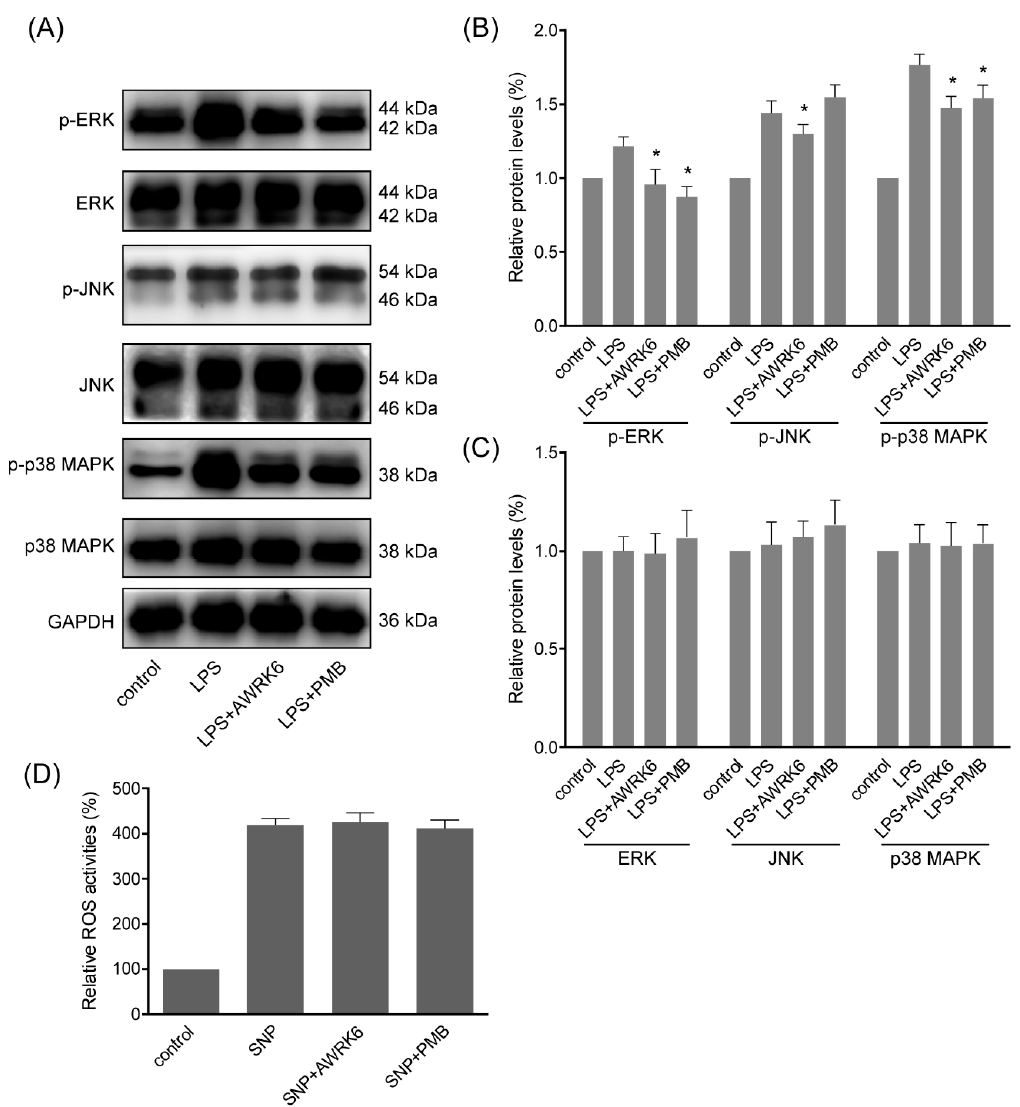
Figure 4. MAPKs were involved in the protection of AWRK6 against liver injury. ( A ) The phosphorylation and total proteins of MAPKs including ERK, JNK and p38 MAPK in HepG2 cells were analyzed by western blotting, following the treatment with LPS (40 µ g/mL) and AWRK6 (200 µ g/mL) for 2 h. ( B ) The phosphorylation of MAPKs was analyzed by ImageJ. ( C ) The total proteins of MAPKs were analyzed by ImageJ. ( D ) The ROS level in HepG2 cells treated by 400 µ M sodium nitroprusside (SNP) with/without AWRK6 at 200 µ g/mL for 6 h, assayed by Reactive Oxygen Species Assay Kit. The results were presented as fluorescence intensity, percent of control. * p < 0.05 compared with the LPS groups.